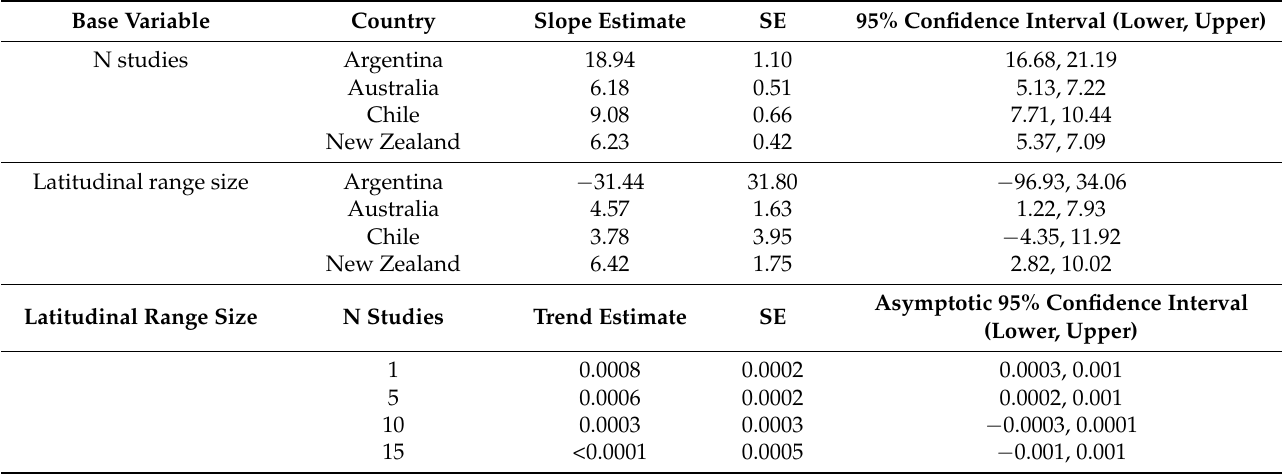
Table A1. Slope average estimates describing the effect of study effort (number of studies) and latitudinal range size on the number of parasite taxa reported from galaxiid fishes from each geographical region.